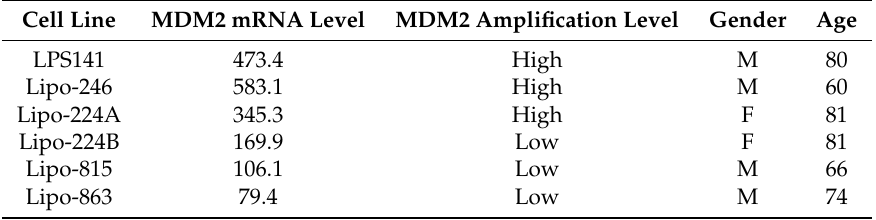
Table 1. Clinical and molecular characteristics of DDLPS cell